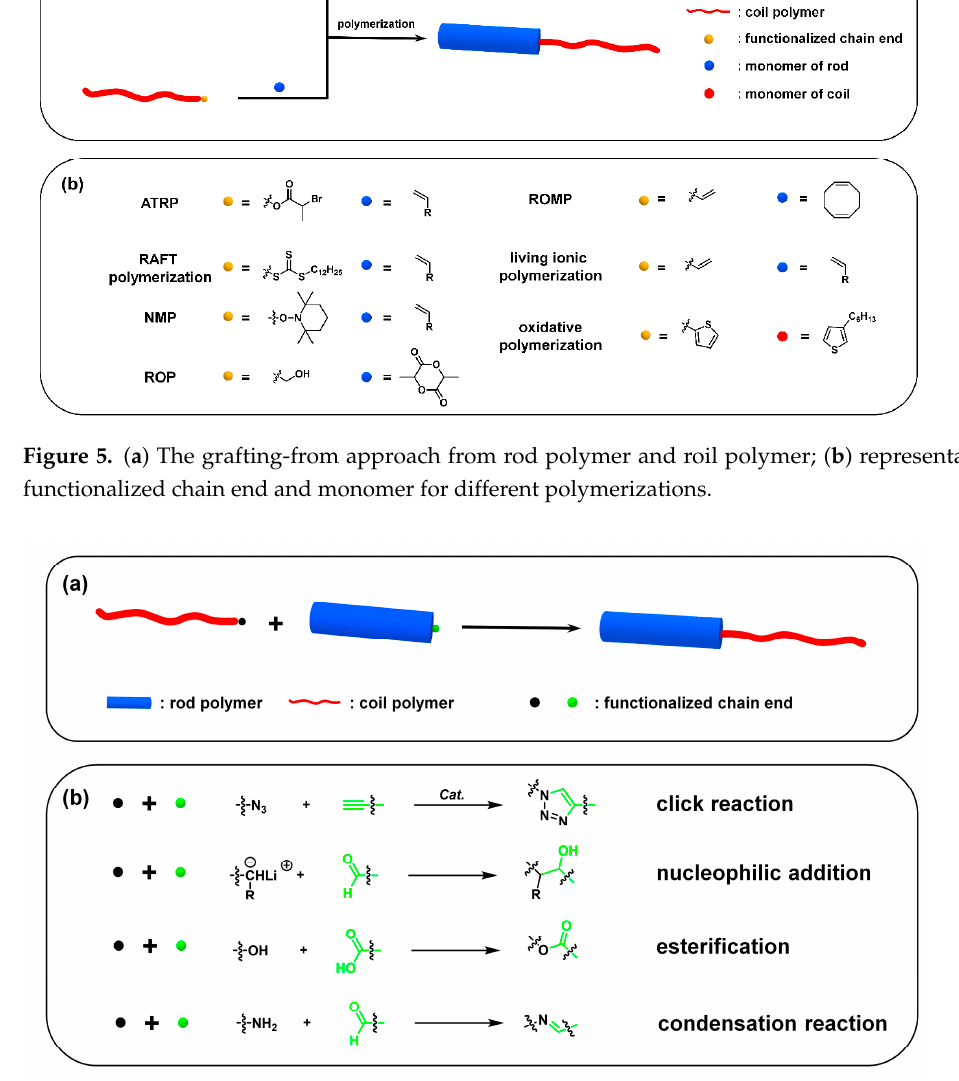
Figure 6. ( a ) The grafting-onto approach; ( b ) representative functionalized chain ends and reaction types.